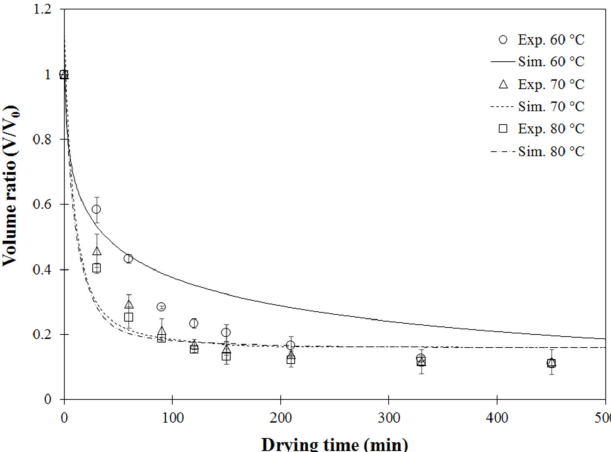
Figure 5. Validation results of shrinkage ratio of carrot cubes as a function of drying time at (circle) 60 ◦ C, (triangle) 70 ◦ C and (square) 80 ◦ C.